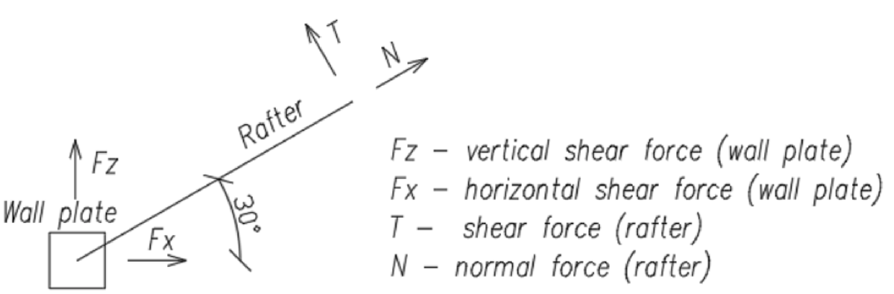
Figure 13. Comparison of the internal forces of the rafters (T, N) and those occurring in the wall plate ( F z , F x ). Based on the previous results (tables from Point 6.2), the maximum values of shear forces and normal forces were assumed. These forces have the direction of the vector consistent with the local arrangement of the rafters. Therefore, in order to calculate the vertical force in the anchor, it was necessary to add up the cosine of the shear force with the sine of the normal